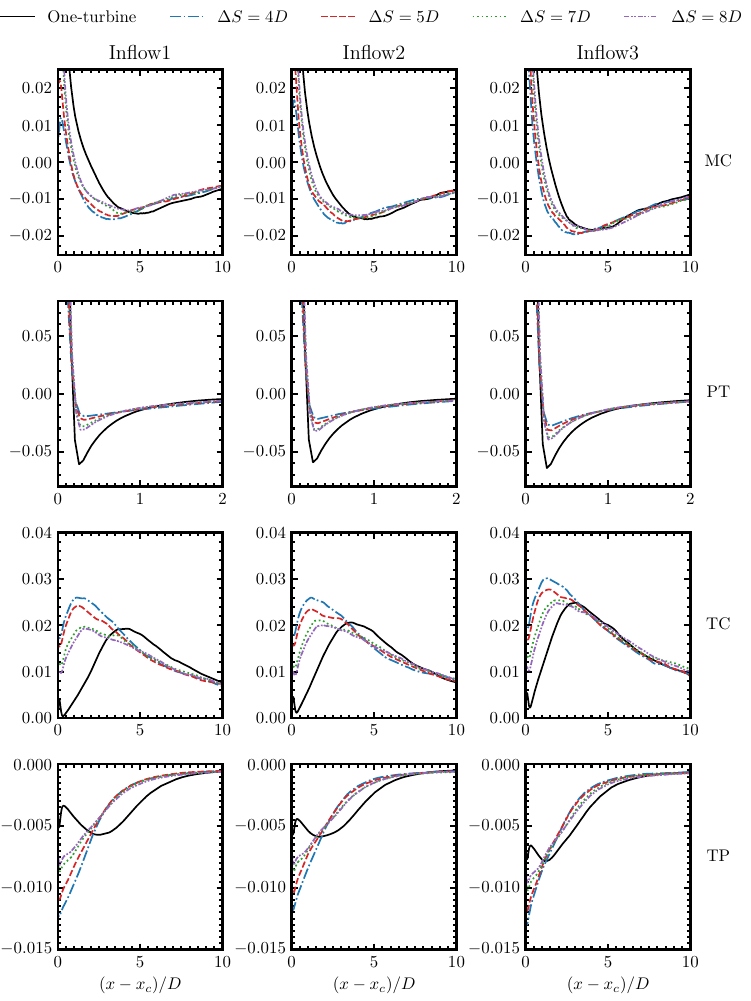
Figure 12. Comparison of the MC, PT, TC and TP terms in the wake of the waked turbine of the two-turbine cases with the stand-alone turbine for different turbine spacings and different inflows. Different terms are normalized using U hub and D